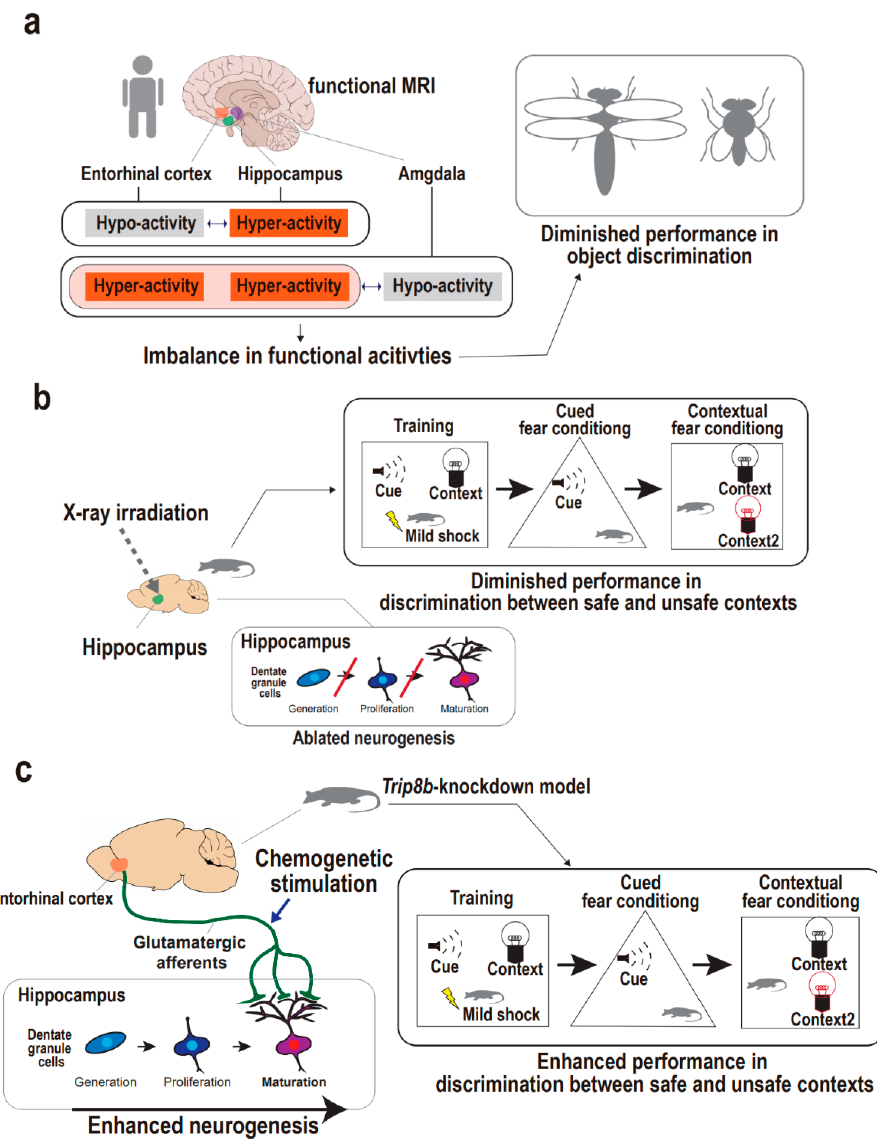
Figure 3. Supportive findings for entorhinal cortex-regulated hippocampal neurogenesis in the regulation of pattern sepa- ration. ( a ) Functional activities of upper hippocampal circuit regions including the entorhinal cortex in the regulation of human pattern separation. Imbalances in functional activities of the entorhinal cortex, hippocampus, and amygdala are ac- companied with the diminished ability for object discrimination in humans. ( b ) Hippocampal neurogenesis in the regulation of animal pattern separation. X-ray irradiation on hippocampus results in ablated neurogenesis in mice, which demon- strate the diminished discrimination between the safe and unsafe representations in the contextual fear conditioning task. ( c ) Entorhinal–hippocampal circuitry and hippocampal neurogenesis in the regulation of animal pattern separation. Chemo- genetic stimulation of entorhinal cortex results in enhanced neurogenesis in Trip8b -knockdown mouse, which is accompanied by the enhanced discrimination between safe and unsafe contexts in the contextual fear conditioning